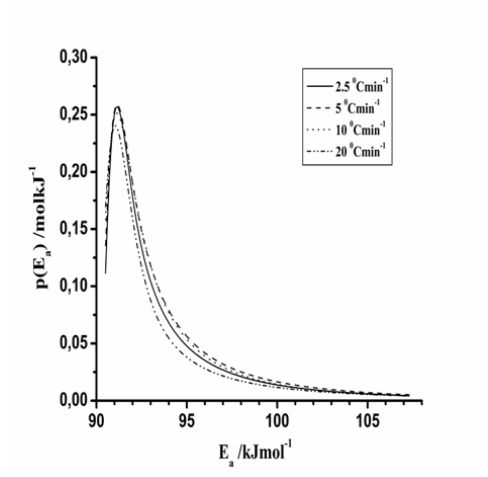
Figure 9 – The influence of the heating rate on the shape and the basic characteristics of the density distribution function of the apparent activation energies (p(E a ) was calculated from Eq. (22)), for the non-isothermal reduction process of nickel oxide under hydrogen